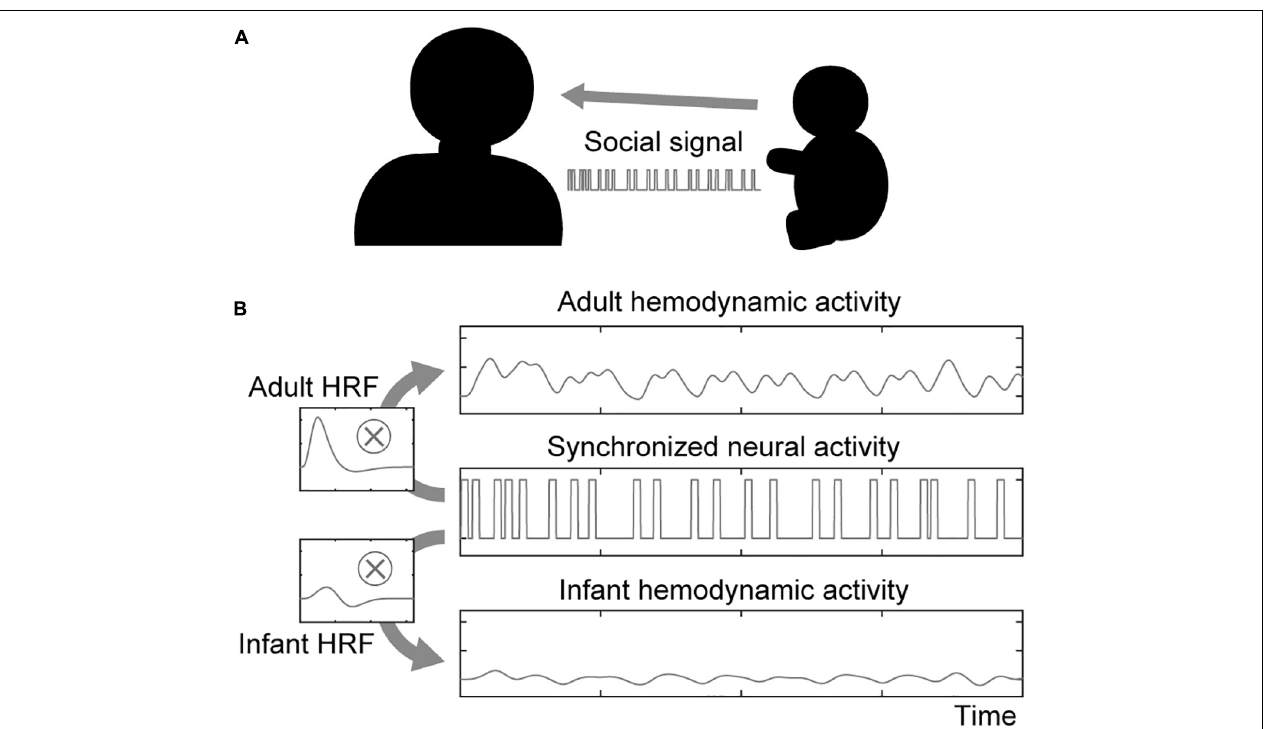
FIGURE 1 | Illustration of the social signal model. (A) An interacting dyad comprising an adult and an infant is assumed in the social signal model. They send and receive social signals each other. (B) Neural activity in both the sender’s and receiver’s brains associated with social signal processing is synchronized upon sharing social signal events. The hemodynamic activity of each participant is modeled by boxcar-shaped neural activation convolved with the HRF.